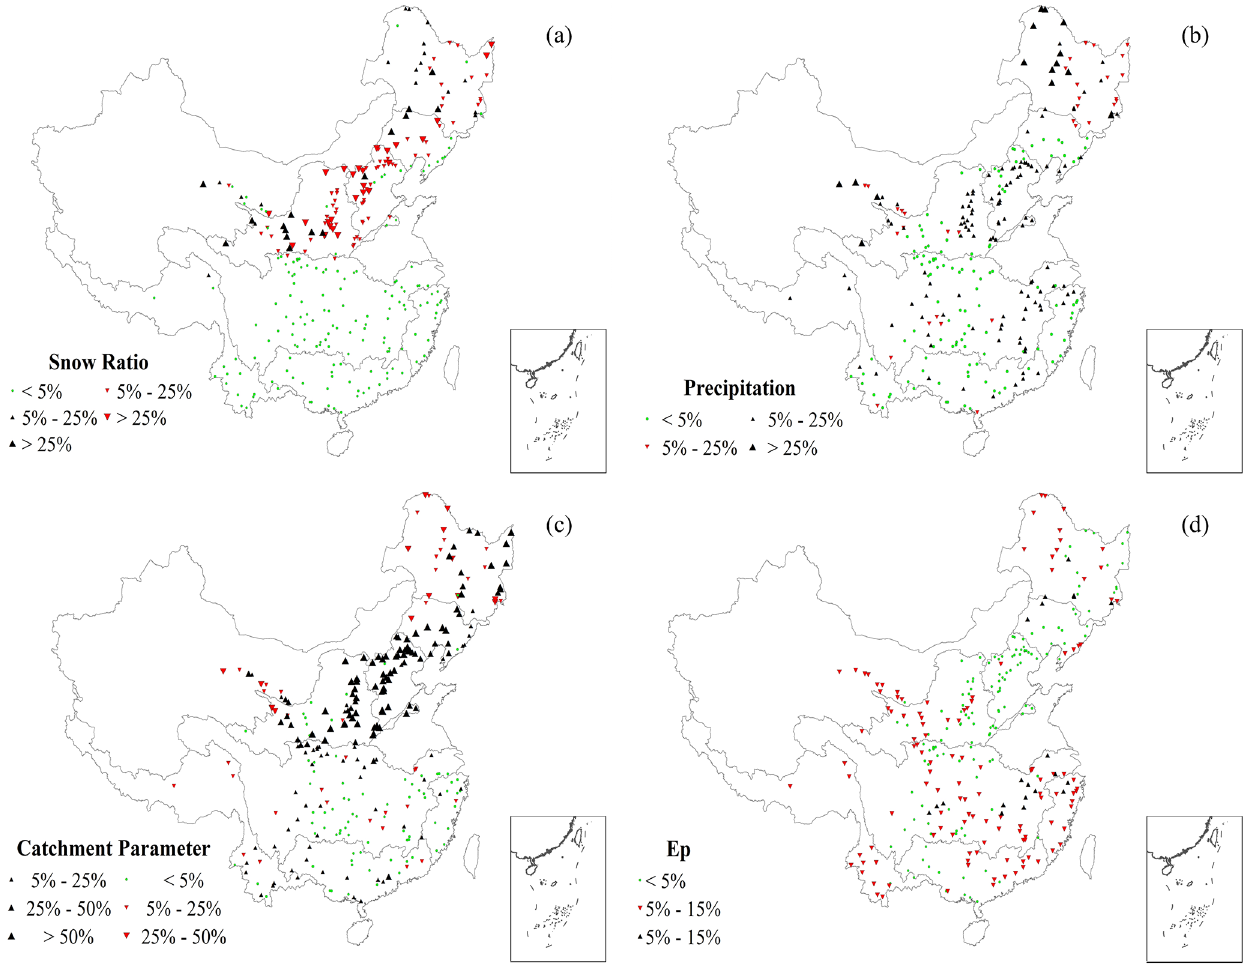
Figure 7. Relative contributions of (a) snow ratio, (b) precipitation, (c) specific catchment parameter, and (d) potential evapotranspiration variance to change in mean annual runoff. Upward triangle represents the positive relative contribution of the variable to change in runoff, while downward triangle represents the